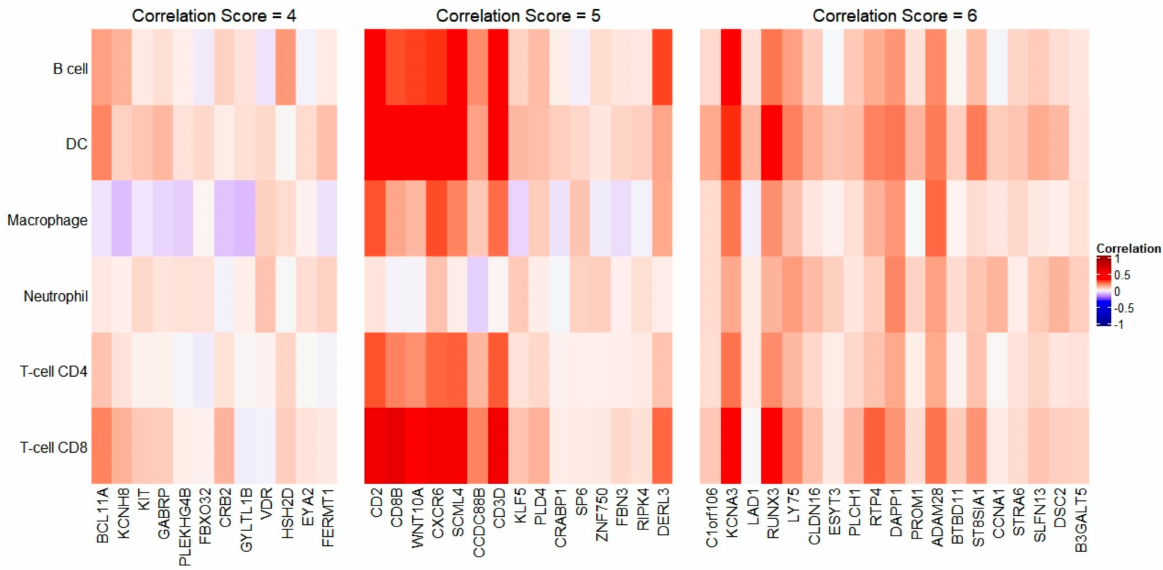
Figure 4. Association of immune cell infiltration and female-biased genes in BC. Only genes with a positive correlation score identified in four or more immune cell types were selected. Boxed regions signify candidate genes with positive correlation in most immune cell types. Table 5. Selected female-biased genes in BC and X-linked miRNA related to breast cancer with inverse correlation.